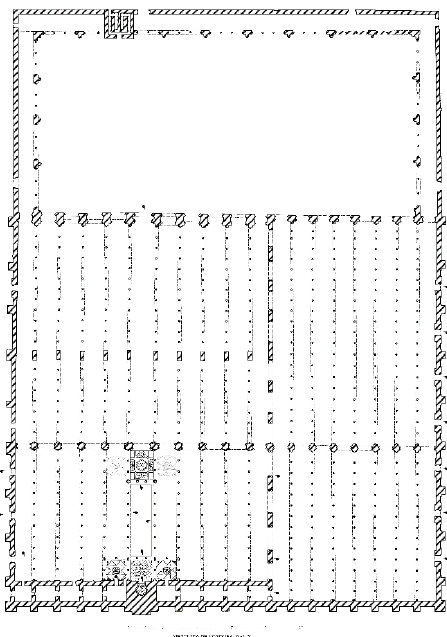
Figure 10. Plan of the Great Mosque of Cordoba. The signs indicate the location of the inscriptions. Based on the plan of A. Almagro (Calvo Capilla 2014a).